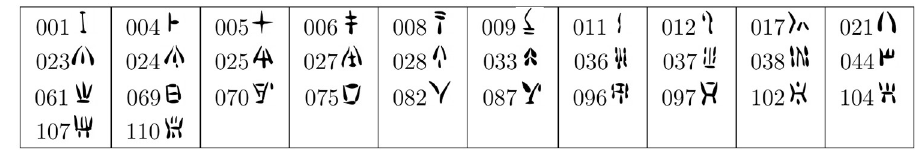
Fig 10. 32 consensual signs attested both in the Other and Tablets subsets.